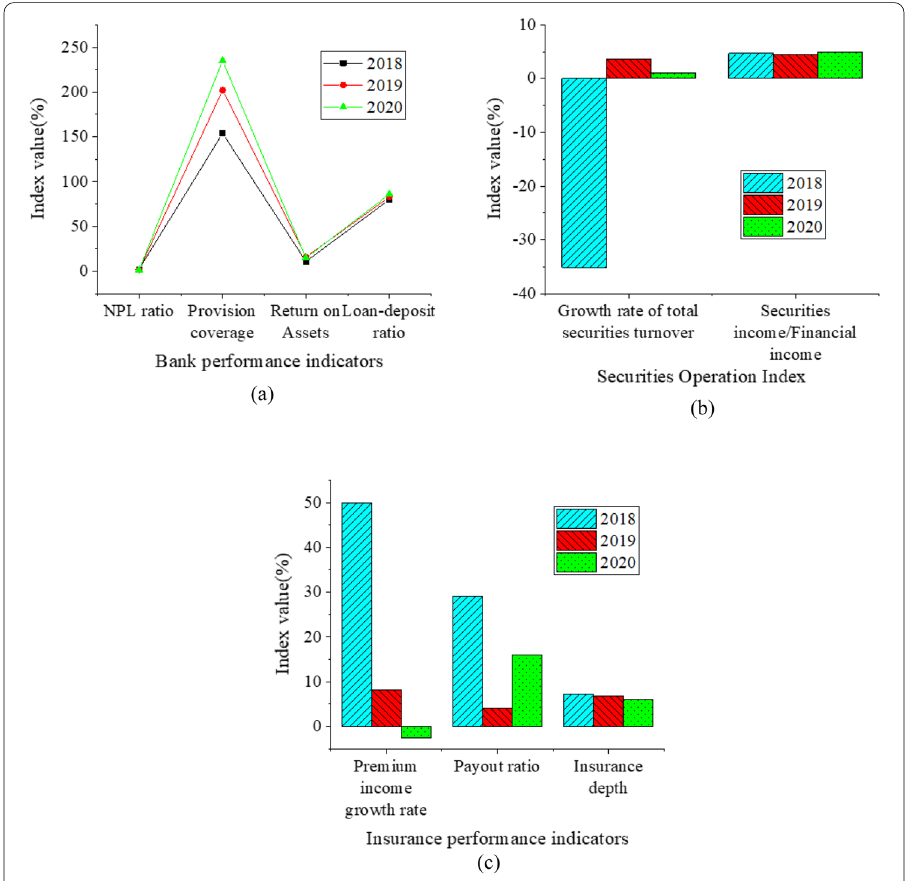
Fig. 14 Factors of regional financial institutions ( a bank performance indicators; b securities performance indicators; c insurance performance